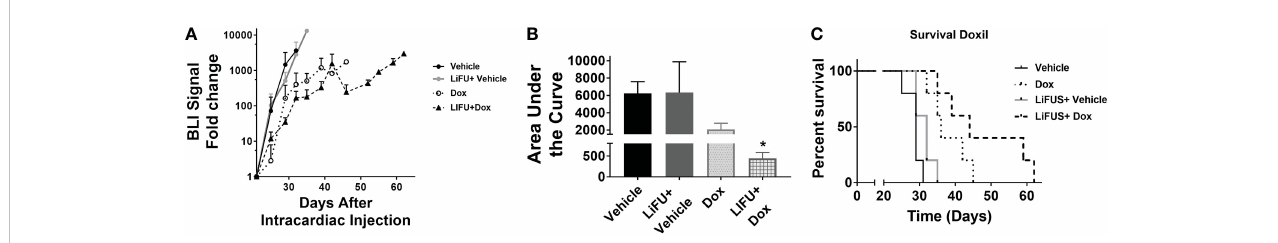
FIGURE 5 Concurrent LIFU+ standard of care Doxil decreases tumor burden and increases survival non-signi fi cantly. (A) BLI signal versus time in mice with treatment beginning on day 21. (B) Area under curve for representative tumor burden shows no signi fi cant difference (n=5-7) (C) Kaplan-Meier survival plot of mice starting 21 days after intracardiac injection of MDA-MB-231Br breast cancer cells. * p<0.01.